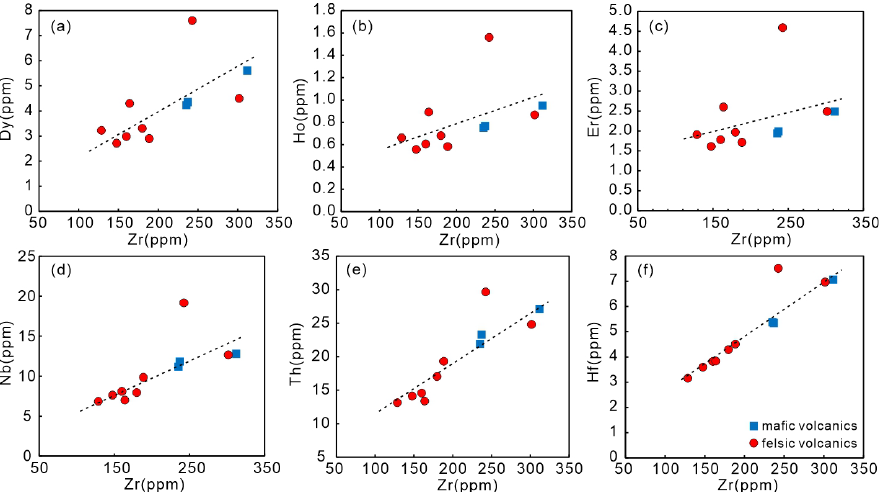
Figure 10. ( a ) Zr vs. Dy diagram , ( b ) Zr vs. Ho diagram , ( c ) Zr vs. Er diagram , ( d ) Zr vs. Nb diagram , ( e ) Zr vs. Th diagram, and ( f ) Zr vs. Hf diagram of bimodal volcanic rocks from the Maoniushan Formation.